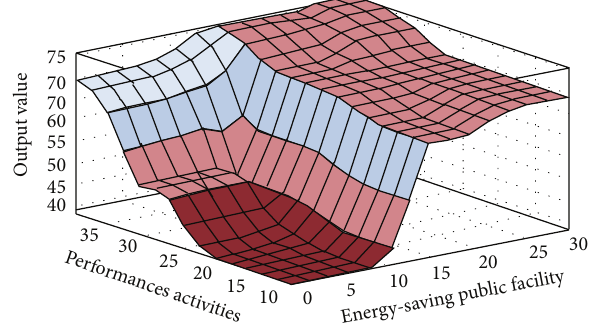
Figure 5: Input and output 3D mapping (performances activities and problem-based learning).